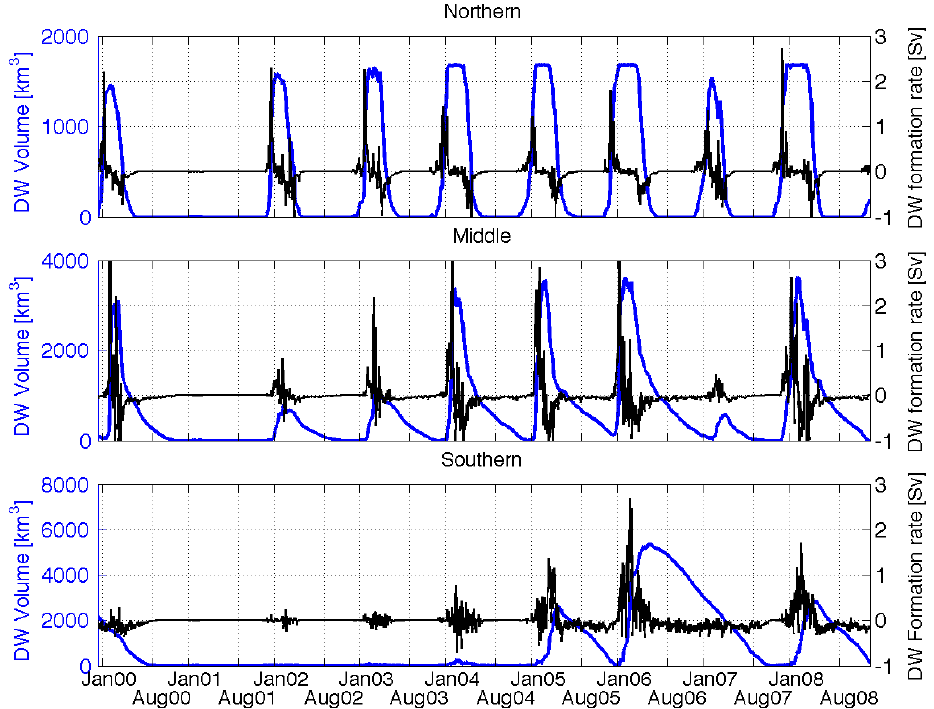
Fig. 11 Daily time-series of total volume of water (km 3 ) with sigma_t > 29.2 (blue line and left Y axis) in Northern, Middle and Southern sub-basins, together with the relative formation/dissipation Fig. 11. Daily time-series of total volume of water (km 3 ) with sigma- t > 29.2 (blue line and left Y-axis) in Northern, Middle and Southern rate expressed in Sv (black line and right Y axis). sub-basins, together with the relative formation/dissipation rate expressed in Sv (black line and right